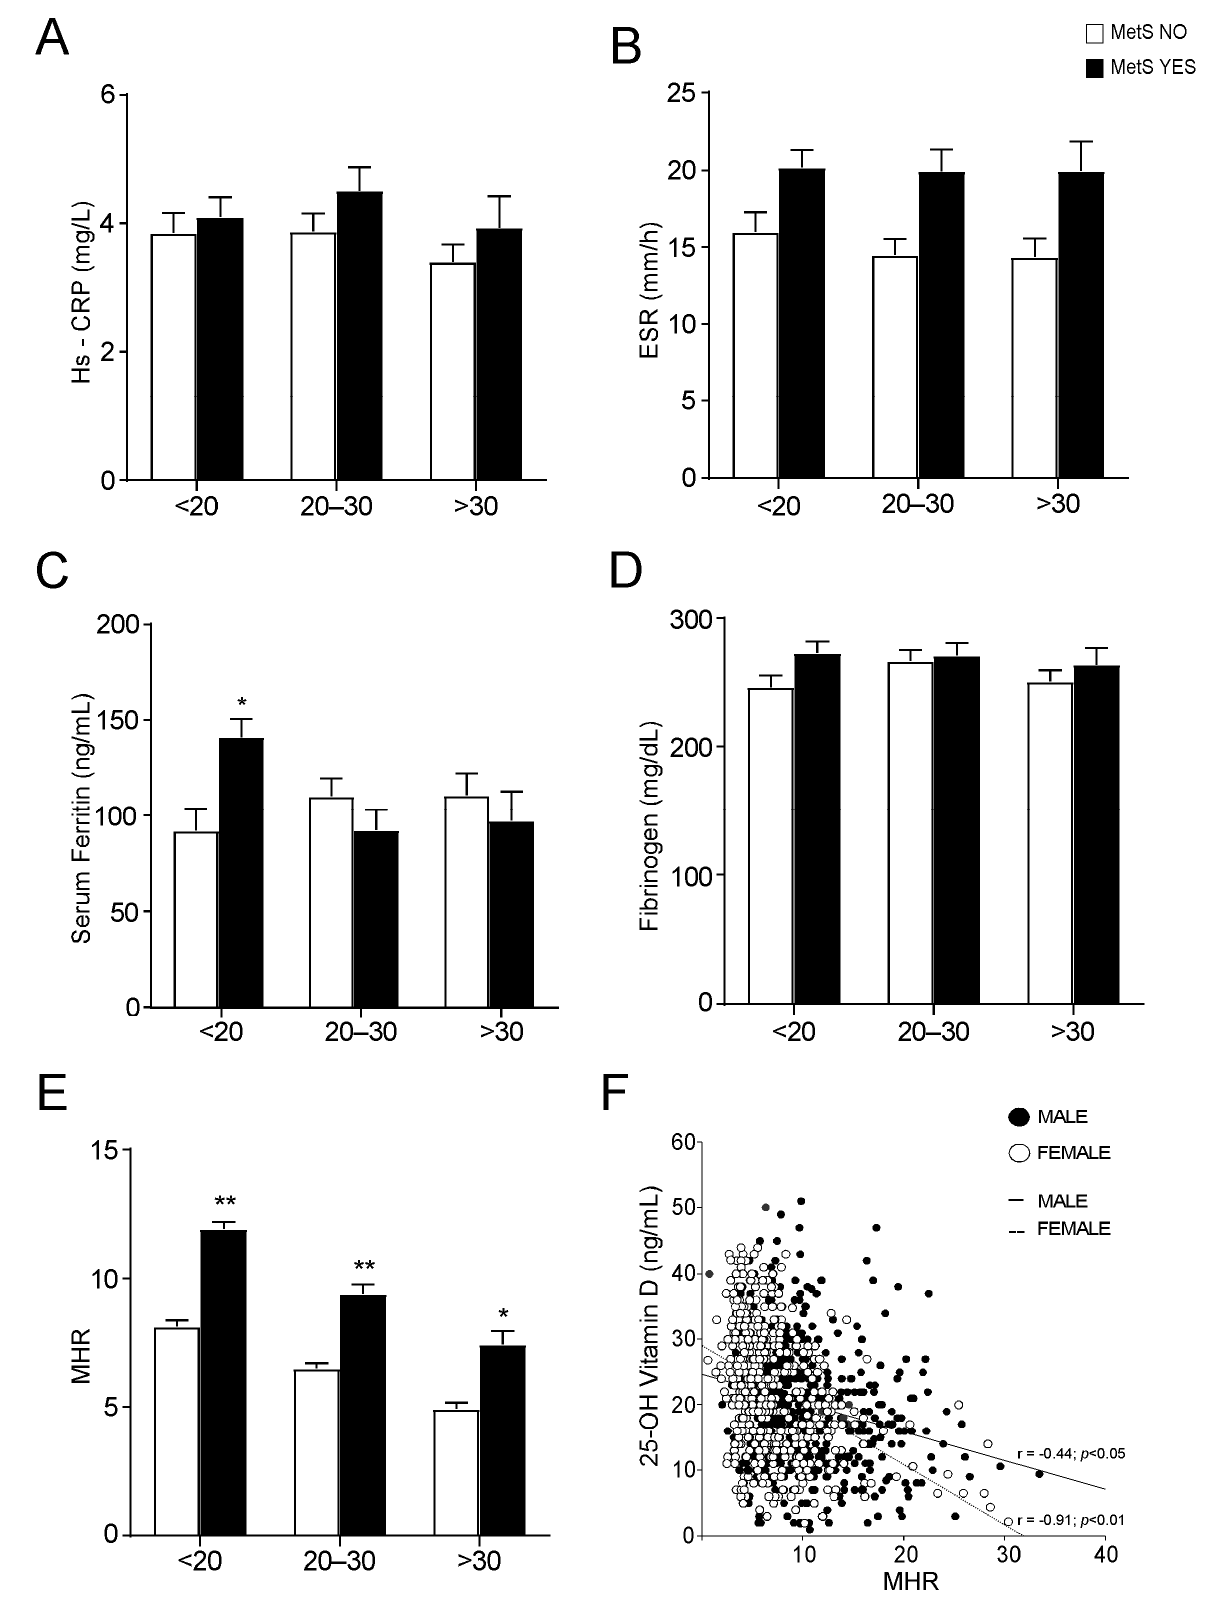
Figure 4. Evaluation of serum inflammation markers and Monocyte-to-HDL ratio in non-metabolic and metabolic subjects, divided by 25-OH vitamin D levels. ( A – D ) Comparison of serum inflammation markers in non-metabolic (MetS NO) and MetS (MetS YES) subjects, divided by 25-OH vitamin D levels. Data is presented as mean ± SEM. Statistical significance was assessed by Student